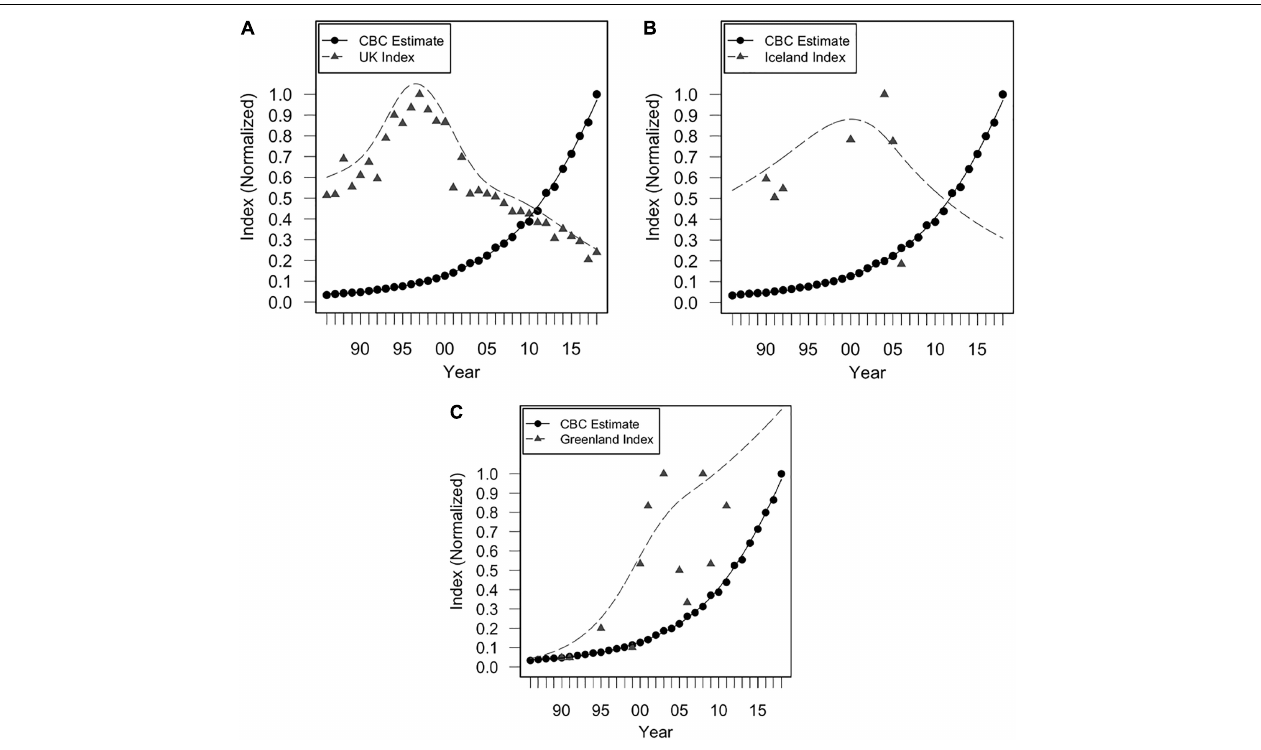
FIGURE 4 | Indices of annual breeding population size from 1986 to 2018 for (A) the UK, (B) Iceland (colony of Midnesheidi), and (C) Greenland (colony of Eqaluit), and Christmas Bird Count (CBC) trend estimates of vagrants. Trend estimates are calculated from CBC surveys as estimates of median abundance, using Bayesian hierarchical methods (Soykan et al., 2016; Meehan et al., 2020). Normalized values were obtained by dividing each value in a given dataset by the maximum value of that